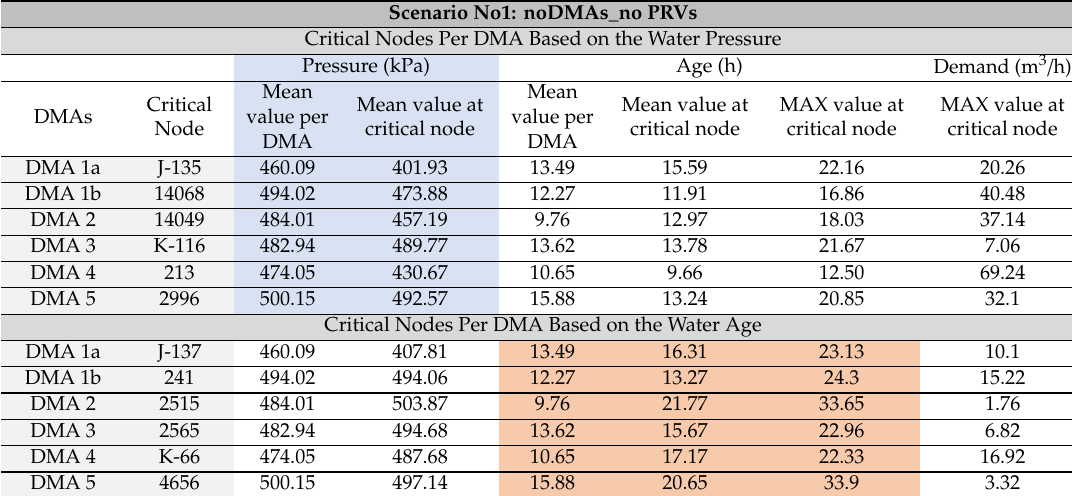
Table 1. Scenario No1 (Initial Settings. No DMAs_No Pressure Reducing Values (PRVs)): (a) Critical nodes per DMA based on the water pressure. Respective water age and water demand values; (b) Critical nodes per DMA based on the water age. Respective water pressure and demand values.